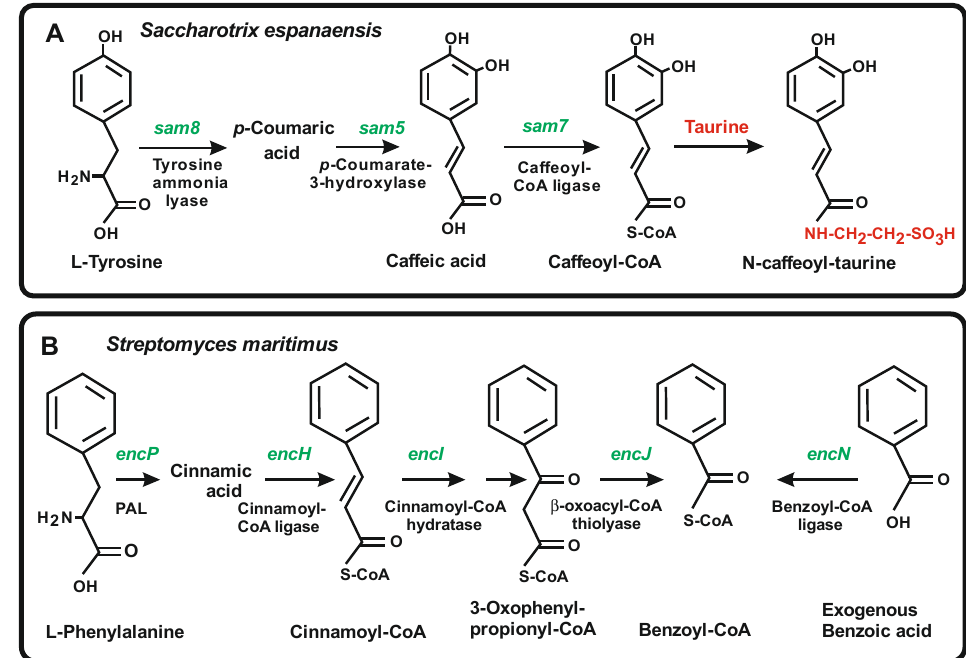
Figure 6. Biosynthetic steps leading from the precursors to the CoA-activated starters used by the chalcone synthases. Early steps in saccharomicins biosynthesis by Saccharotrix espanaensis ( panel A ) and in enterocins biosynthesis by Streptomyces maritimus ( panel B ). The names of the starter units, the intermediates and the enzymes involved in every step are indicated. The genes encoding the enzymes are shown in green. Note that benzoyl-CoA can be formed in S. maritimus either from endogenous 3-oxophenylpropionyl-CoA or from exogenous benzoic acid (see